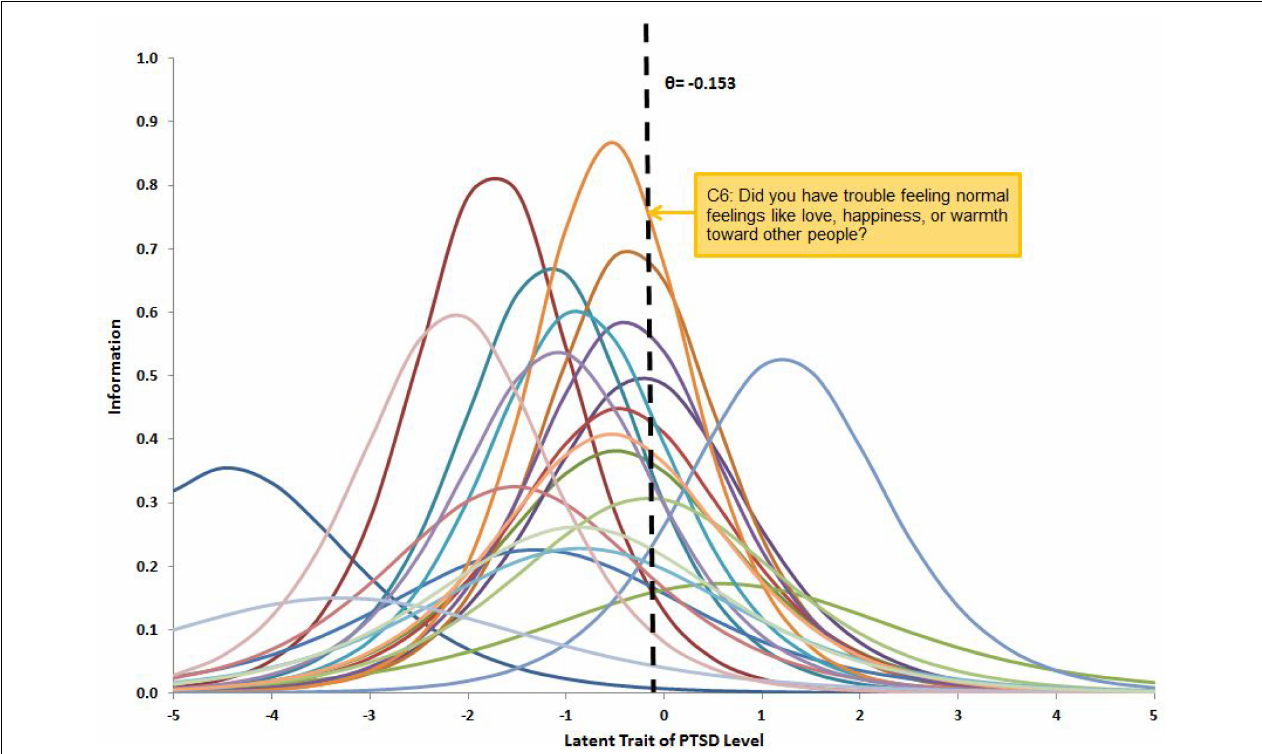
FIGURE 1 | Item information for 21 items in NCS-R questionnaire corresponding to DSM-IV PTSD diagnosis criteria. The cutoff point was estimated at − 0.15 on latent scale to distinguish PTSD and non-PTSD. Item C6 is the most informative item, having the highest intersection value with the cutoff line.